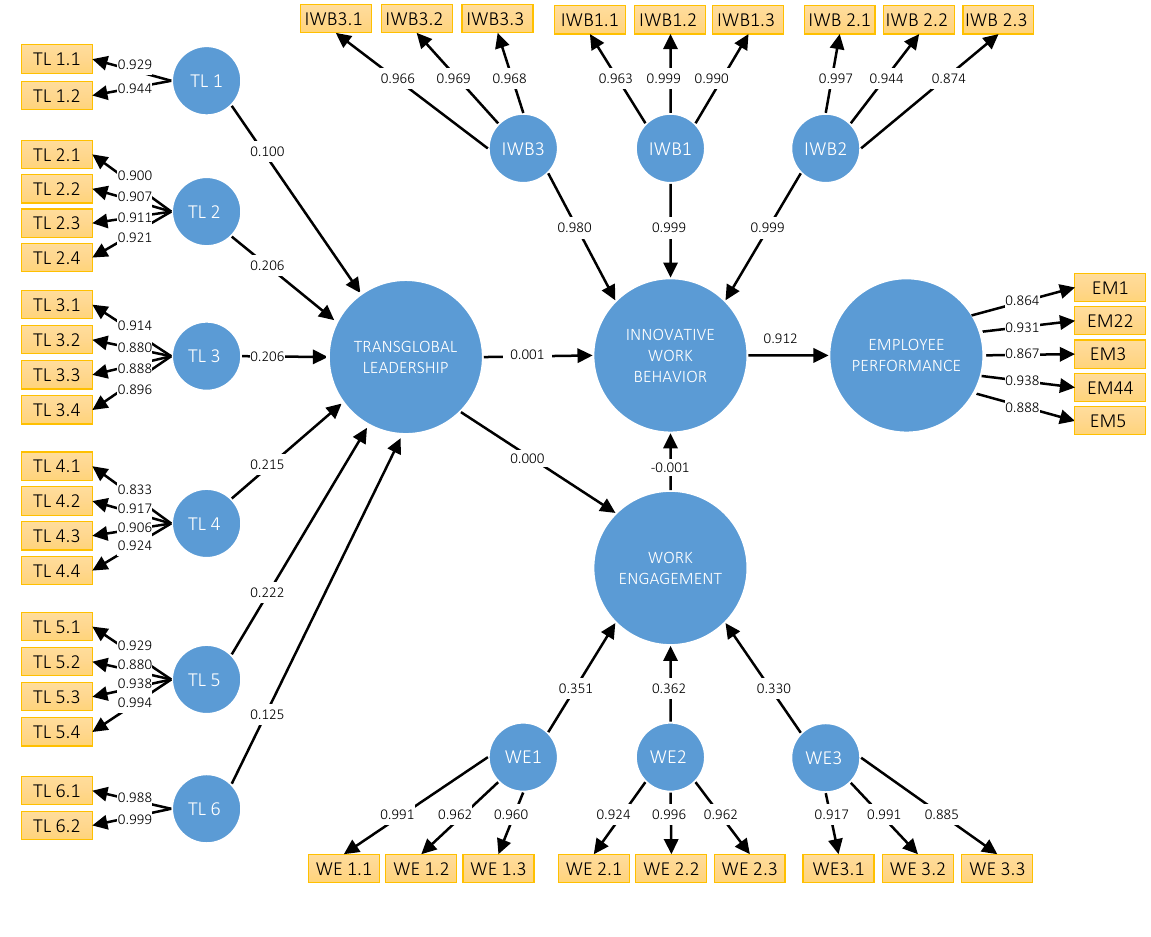
Figure 2. Finding model